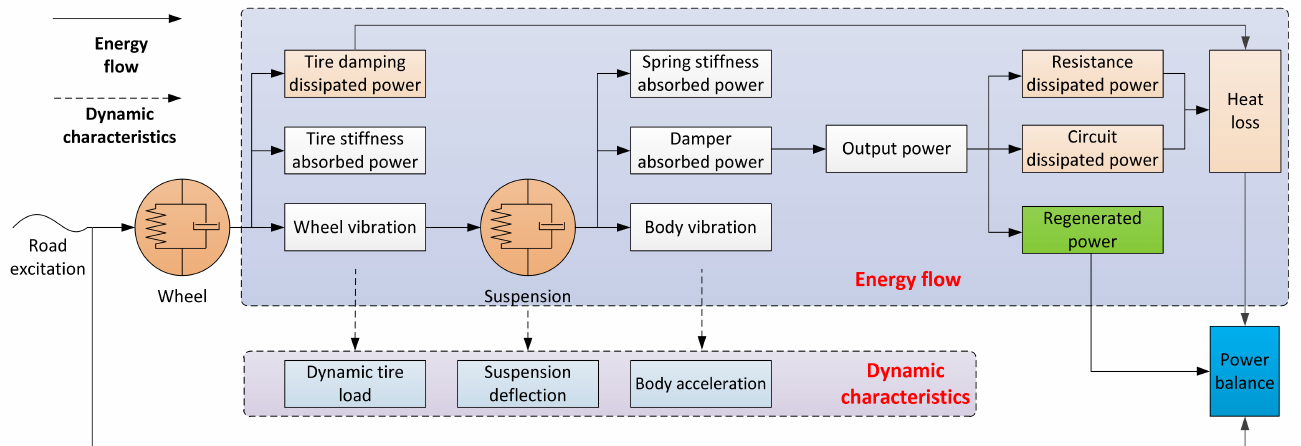
Figure 2. Energy flow of one-quarter suspension